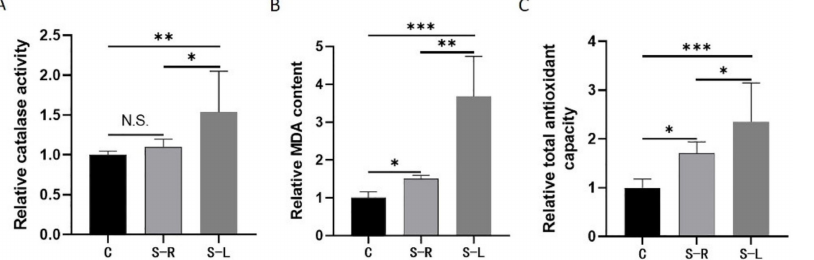
Figure 3. Increased levels of oxidative stress in atrophy model. ( A ) Relative catalase activity analysis. ( B ) Relative MDA content analysis. ( C ) Relative total antioxidant capacity analysis. Data are presented as mean ± SEM ( n = 3 biologically independent samples). * p < 0.05; ** p < 0.01; *** p < 0.001 (Student’s t